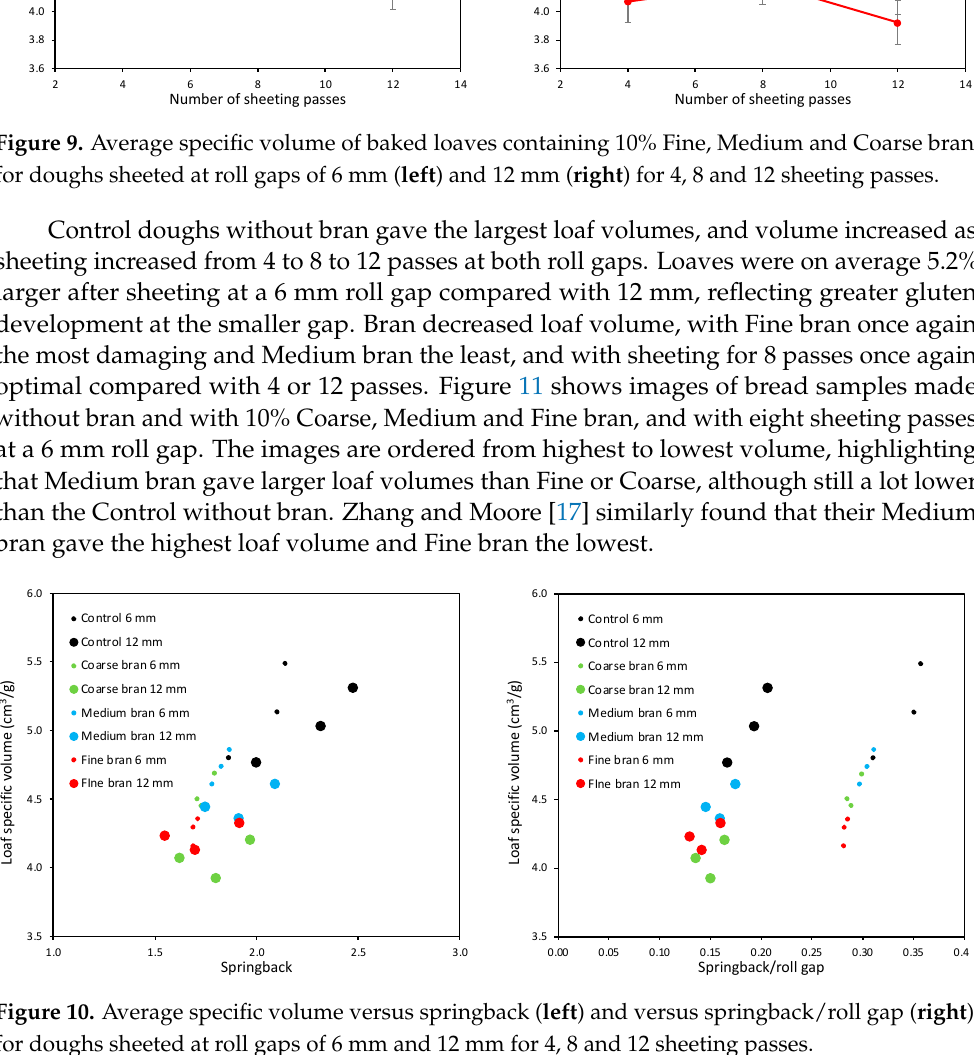
Figure 10. Average specific volume versus springback ( left ) and versus springback/roll gap ( right ), for doughs sheeted at roll gaps of 6 mm and 12 mm for 4, 8 and 12 sheeting passes. Control doughs without bran gave the largest loaf volumes, and volume increased as sheeting increased from 4 to 8 to 12 passes at both roll gaps. Loaves were on average 5.2% larger after sheeting at a 6 mm roll gap compared with 12 mm, reflecting greater gluten development at the smaller gap. Bran decreased loaf volume, with Fine bran once again the most damaging and Medium bran the least, and with sheeting for 8 passes once again optimal compared with 4 or 12 passes. Figure 11 shows images of bread samples made without bran and with 10% Coarse, Medium and Fine bran, and with eight sheeting passes at a 6 mm roll gap. The images are ordered from highest to lowest volume, high- lighting that Medium bran gave larger loaf volumes than Fine or Coarse, although still a lot lower than the Control without bran. Zhang and Moore [17] similarly found that their Medium bran gave the highest loaf volume and Fine bran the lowest. Figure 11. Effects of bran particle size on loaf volumes and crumb structures, for doughs containing 10% Coarse, Medium and Fine bran, sheeted at a roll gap of 12 mm for 8 sheeting passes. As well as giving a large loaf volume, good gluten development should retard coa- lescence of bubbles during proving and baking, leading to a large number of gas cells with small diameters and thin walls. Figure 12 shows the number of cells, the average cell di- ameter and the average wall thickness as affected by bran particle size and sheeting re- gime. For the Control dough, as the number of sheeting passes increased, the number of gas cells increased for doughs sheeted at both 6 and 12 mm roll gaps (Figure 12, top). This is in line with the increased loaf volumes reported in Figure 9 and reflects the enhanced